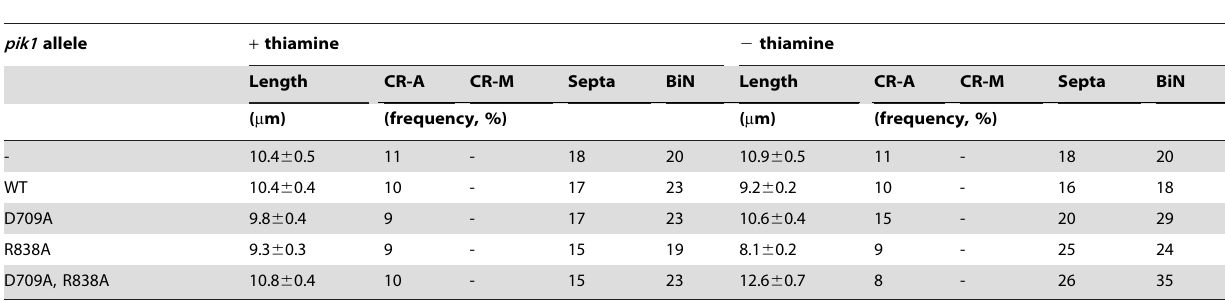
Table 4. Effects of ectopic expression of pik1 alleles on cytokinesis in cdc4 G107S cells.